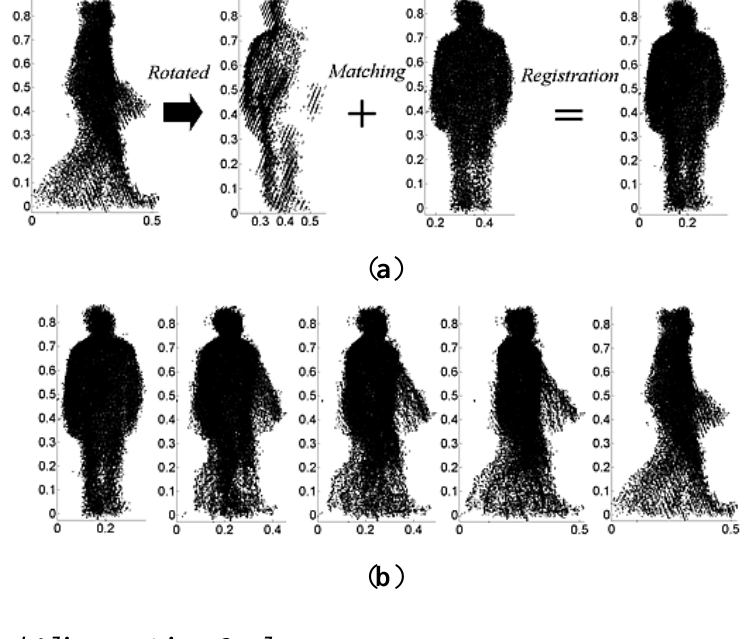
Figure 5. Self-occlusion problem overcome by point cloud registration method: ( a ) gait point cloud registration with θ = 0°, θ = 90° and â = 0°; and (b ) view rotated from min max registered gait without